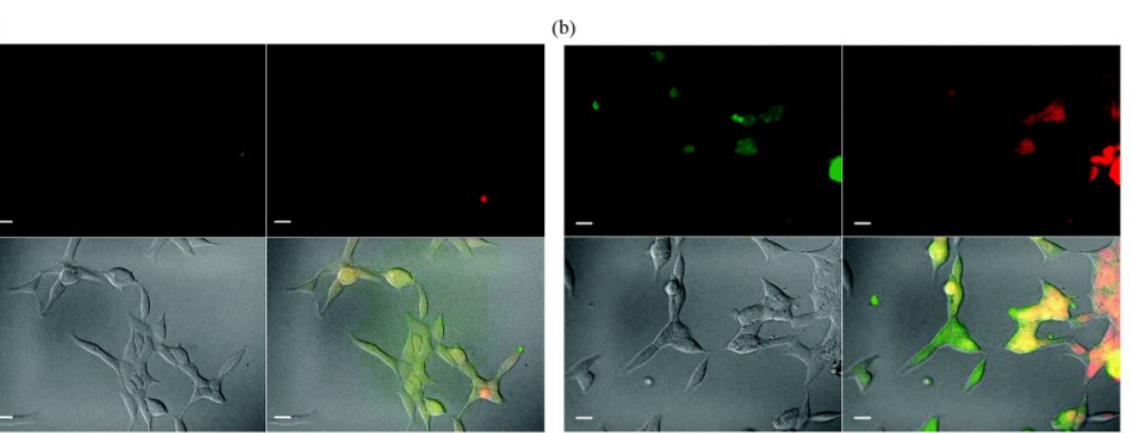
Figure 10. Confocal laser scanning microscopy images of PSMA expressing LNCaP cells after incubation with 100 nM QD-Apt-(Dox) conjugates for 0.5 h at 37 °C, washed two times with PBS buffer, and further incubated at 37 °C for ( a ) 0 h and ( b ) 1.5 h. Dox and QD are shown in red and green, respectively, and the lower right images of each panel represents the overlay of Dox and QD fluorescent. The scale bar is 20 μ m. Reprinted with permission from [47]. Copyright 2007 American Chemical Society.